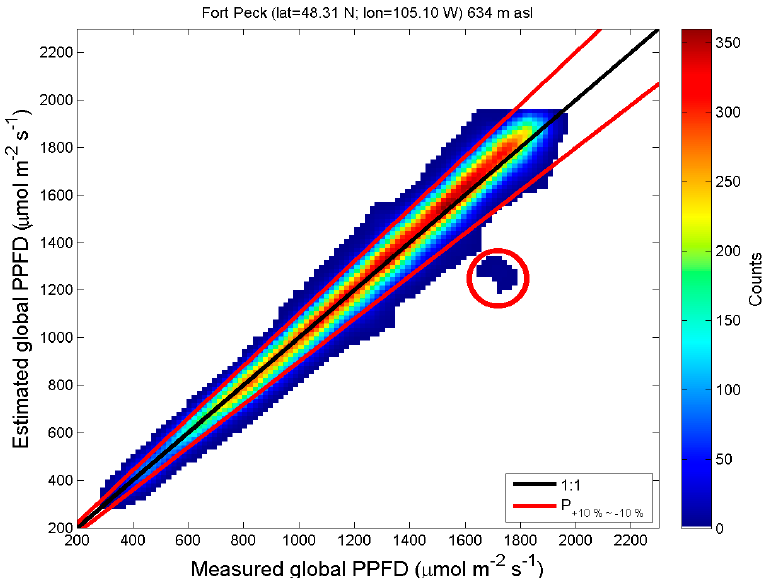
Figure 2. 2D histogram of measured photosynthetic photon flux density (PPFD) and estimates at Fort Peck in cloudless atmospheres. The color bar indicates the number of couples in each bin of 20 µmol m − 2 s − 1 in width. Table 3. Statistics of comparison between the measured global PPFD and estimates. N is the number of data